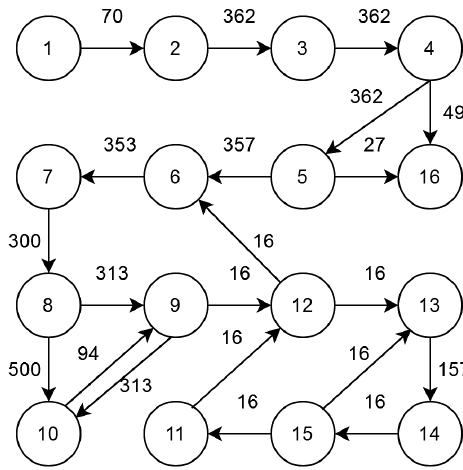
Figure 2. Standard NoC VOPD benchmark.